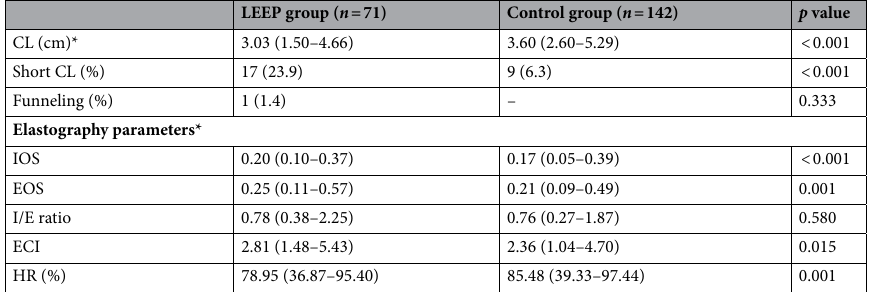
Table 2. Mid-trimester cervical length and cervical elastography parameters of the LEEP group versus the control group. *Median (range). CL cervical length, ECI elasticity contrast index, EOS mean external os strain, HR hardness ratio, IOS internal os strain, LEEP loop electrosurgical excision